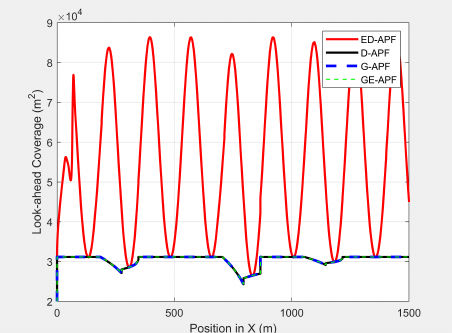
Figure 33. Look-ahead coverage vs. the MGV’s position while moving in an environment with different